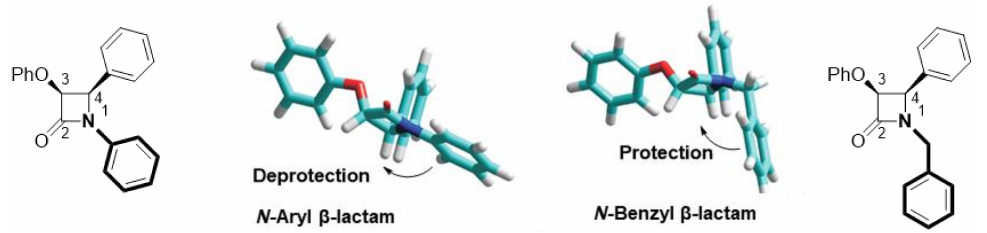
Figure 3. AM1 geometric optimization of N -aryl and N -benzyl β -lactams.